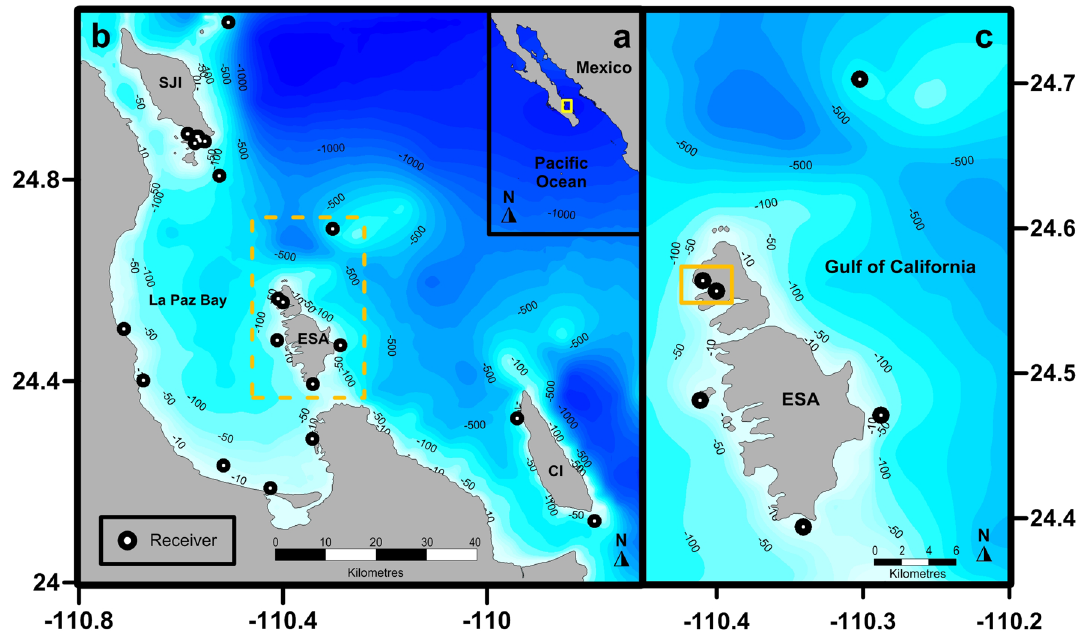
Figure 1. ( a ) Mexican Pacific and Baja California Peninsula. The yellow square located on the southwestern portion of Gulf of California outlines the location of ( b ) La Paz Bay and the surrounding islands of San Jose (SJI), Cerralvo (CI), and the Espiritu Santo Archipelago (ESA) outlined in yellow dashed square. The receiver locations (n = 21) are indicated with black–white dots. ( c ) Mobula munkiana early life stage individuals aggregate in the shallow bay of Ensenada Grande outlined with a yellow square. The map was created using Surface Mapping System (Golden Software, Inc., 1993–2012, https ://www.golde nsoft ware.com/produ cts/surfe r) and the coastline data was extracted from GEODAS-NG (National Geophysical Data Center,